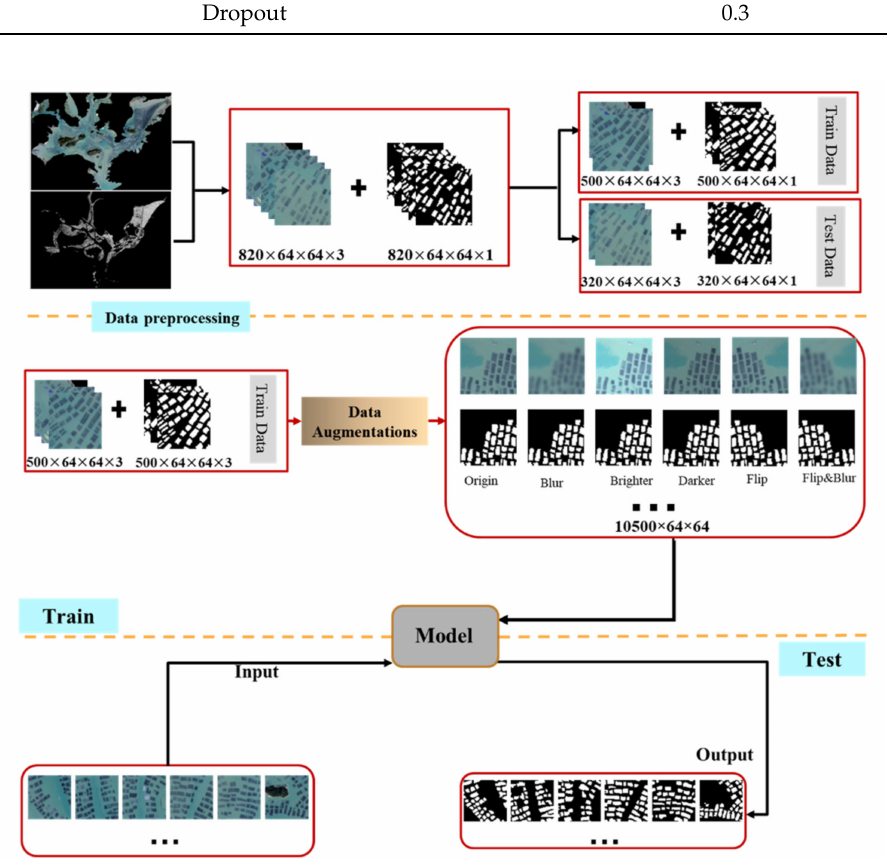
Figure 5. Raft aquaculture area extraction model construction process. The upper, middle, and lower parts of the figure represent the sample making and data augmentation, model training, and prediction,